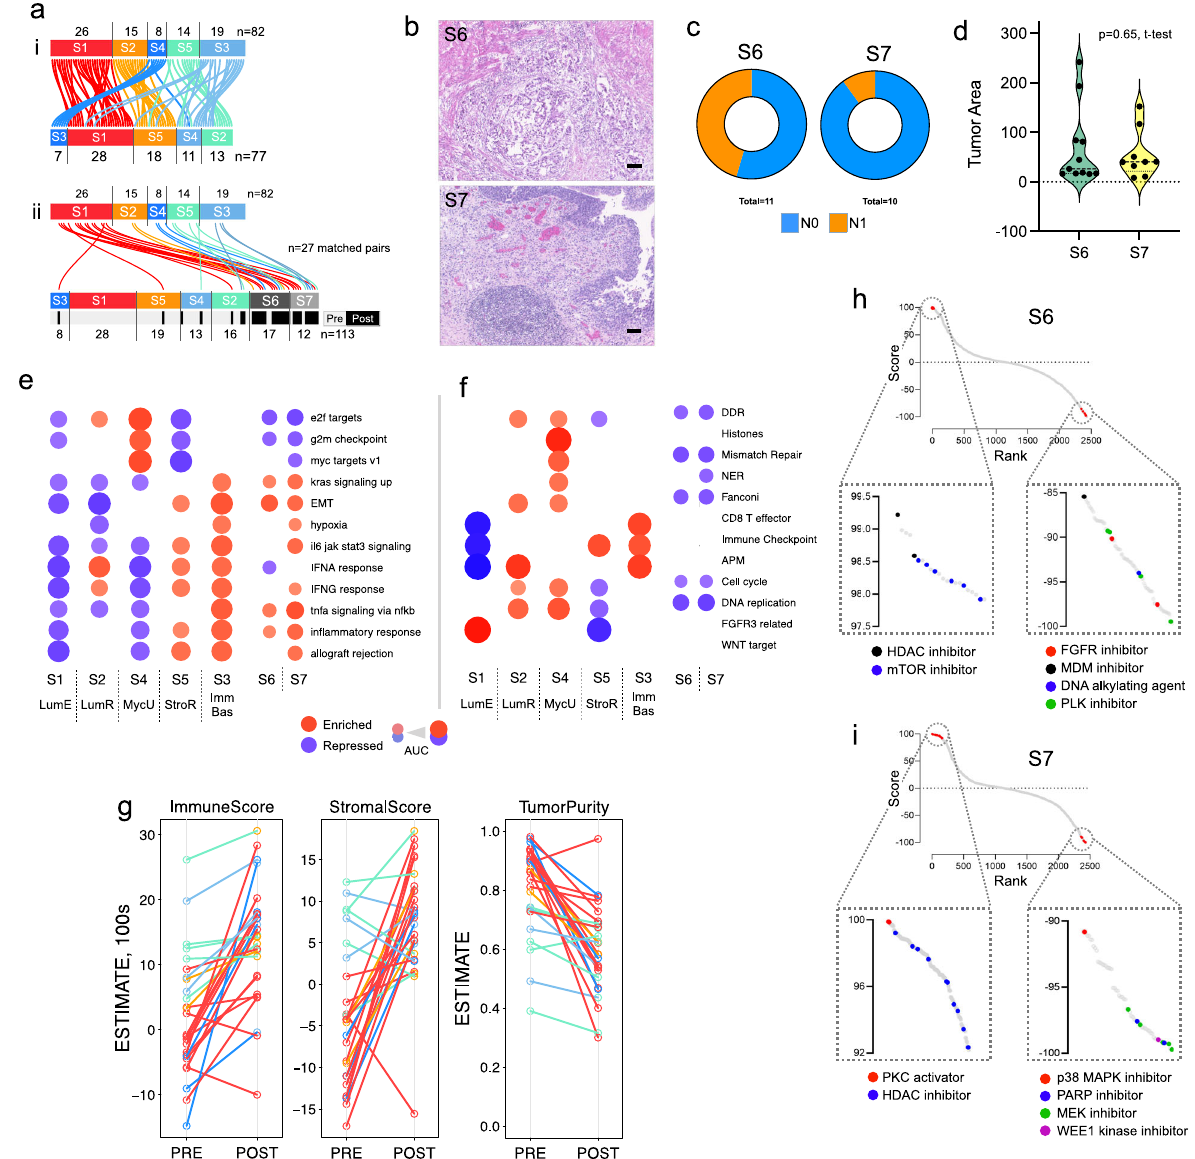
Fig. 5 | Comparison of pre- and post-treatment PURE01 samples. a Sankey-like diagram showing: (above) fi ve unsupervised clusters for pre-treatment samples ( n =82)and(below)sevenclustersforpre+postsamples( n =113).Eachbeziercurve shows the positions of one sample in two consensus clustering solutions. Below, bezier curves are drawn only for the n =27 matched pre-post sample pairs. The n =113clustersarecoloredtoindicatesubtypesthatcorrespondbetweenthe n =82 and n =113clusteringresults.Thegray-blackcovariatetrackindicatespre-andpost- treatment samples in the n =113 clustering solution. A two-sided Fisher exact test that compared pre/post-treatment status to seven consensus subtypes returned p =8.7×10 − 13 ,uncorrectedformultiplecomparisons. b RepresentativeH&E-stained micrographs for post-treatment subtypes S6 and S7. ( ‘ Representative ’ implies manualselection,withno biologicalortechnicalreplicates.)Scalebarsare 0.1mm. c FractionofsamplesinS6( n =11)andS7( n =10)thatwerelymphnodeN0vs.N1at radical cystectomy. d Distributions of tumor areas in subtypes S6 and S7. Results